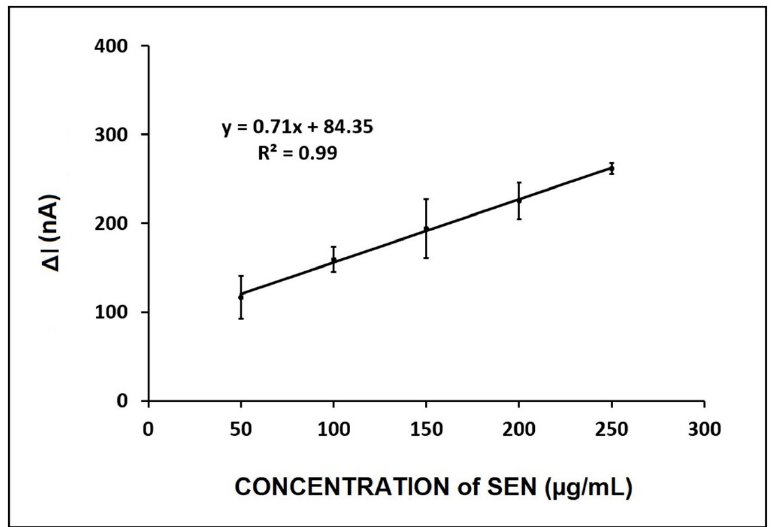
Figure 6. The calibration plot representing the average oxidation signal ( n = 3) in the concentration range of 50–250 µg/mL SEN prepared in 0.5 % flour sample.